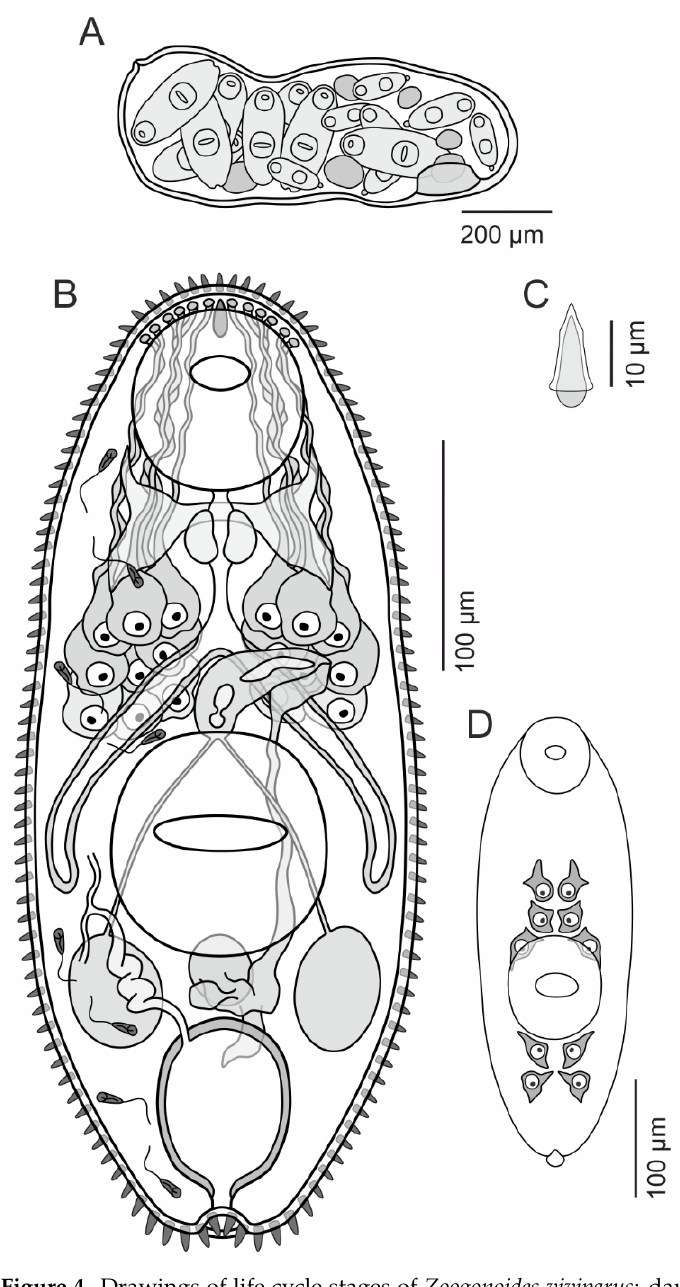
Figure 4. Drawings of life cycle stages of Zoogonoides viviparus : daughter sporocyst ( A ), infective cercaria body structure ( B ), stylet, ventral view ( C ), mucoid gland cells and the tail primordium in underdeveloped cercaria ( D ).